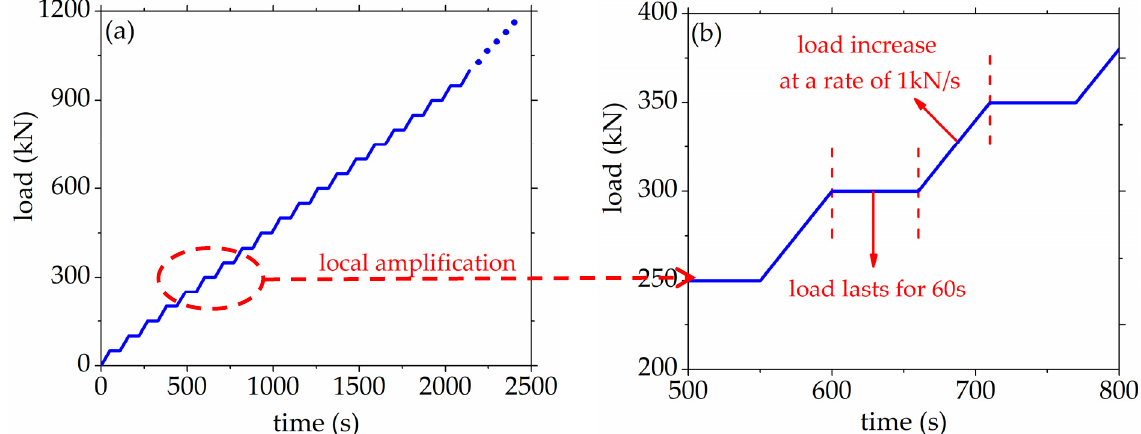
Figure 1. The diagram of experimental layout. ( a ) Cube specimen, ( b ) prism specimen, ( c ) loading diagram. In order to obtain the characteristics of AE elastic wave velocity at different stress levels, this experiment designed a stepping load mode. The loading grads was 50 kN, and the loading rate was 1 kN/s. One loading cycle was as follows: the concrete specimen was loaded for 50 s firstly, and then the loading was kept stable for 60 s. The loading cycle was repeated until the specimen was completely damaged. During the voltage stabilization time of the AE testing system, AE elastic wave velocity was collected. The specific diagram of the loading scheme was shown in Figure 2.